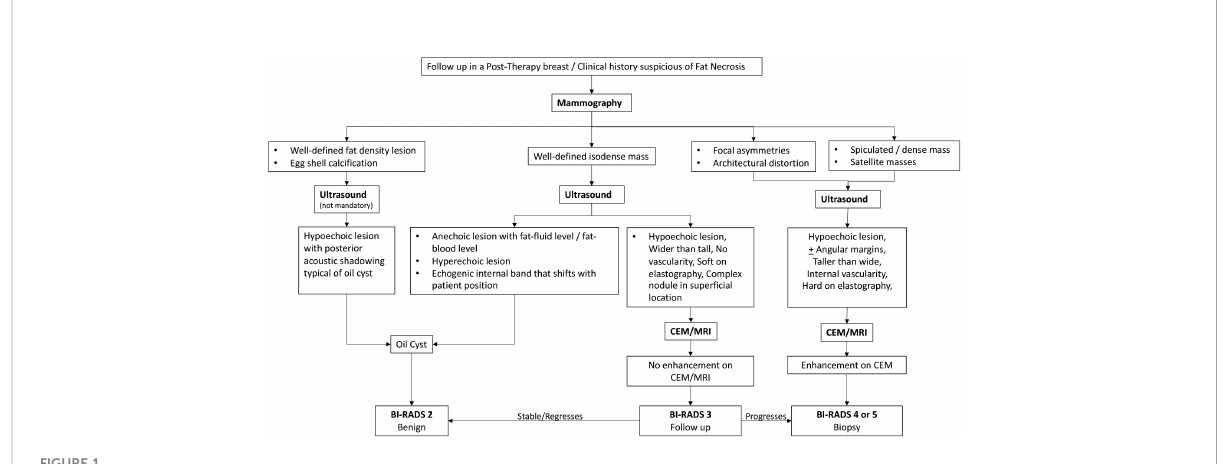
FIGURE 1 Algorithm for the approach to fat necrosis.